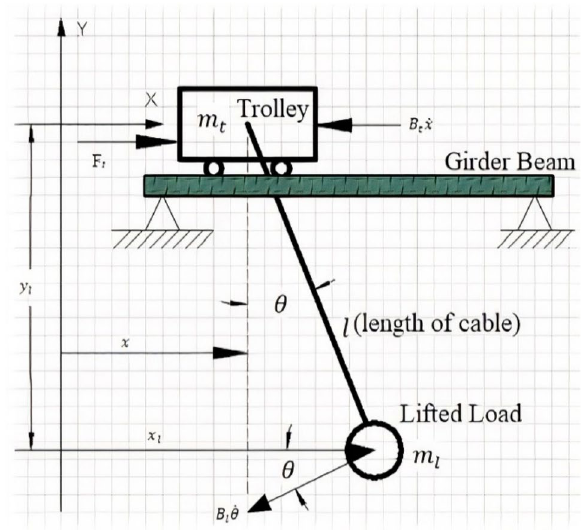
Fig. 2 The schematic representation of a two-dimensional over- head crane system. Where, m t − mass of a trolley, m l − mass of the load to be lifted, l − length of hoisting cable, B t − Viscous damping Coefficient of friction of the trolley, B l − Viscous damping coefficient of friction of the lifted load, θ− swinging angle, ̇𝜃 − angular velocity of the load, x − position of the trolley, ̇ x − the linear velocity of the trolley, x l − x- Coordinate position of the lifted load, y l − y-coordi- nate position of the lifted load, F t − Trolley Control